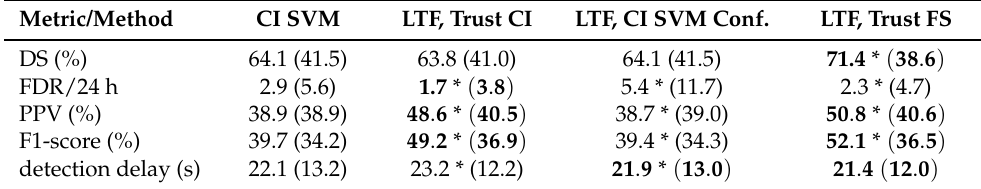
Table 1. Mean (standard deviation) performances of: CI SVM; low-trust filtering (LTF) with the confidences of this SVM (CI SVM conf.); and LTF with trust models trained on CI (trust CI) and FS (trust FS) labels. A statistically significant improvement or degradation in performance compared to the original SVM is denoted by a star. The best result (or not significantly different from the best result) is shown in